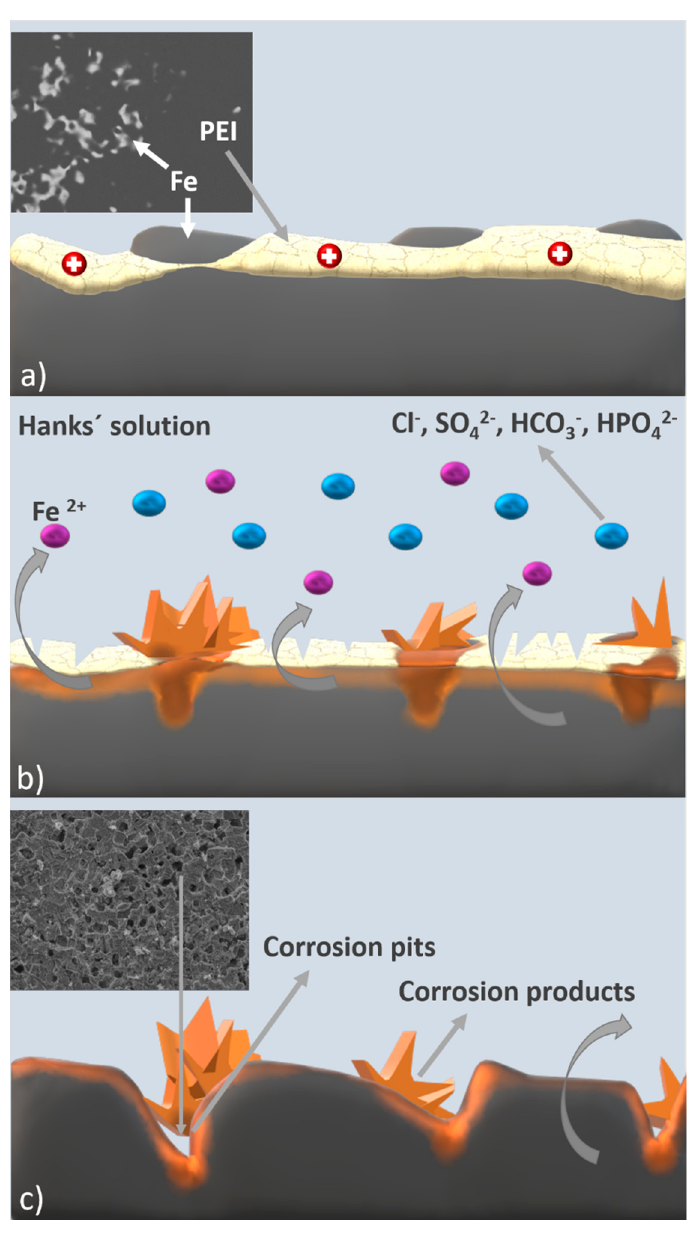
Figure 13. Schematic representation of corrosion processes ongoing on the surface of the Fe-PEI material. ( a ) Polymer-coated sample on-air; ( b ) polymer-coated sample after immersion into Hanks’ solution—PEI layer disruption; ( c ) formation of corrosion pits after 12 weeks of biodegradation. Table 5. pH of Hanks’ solution after 4 to 12 week long immersion of iron-based samples coated with PEI and pure iron foams.